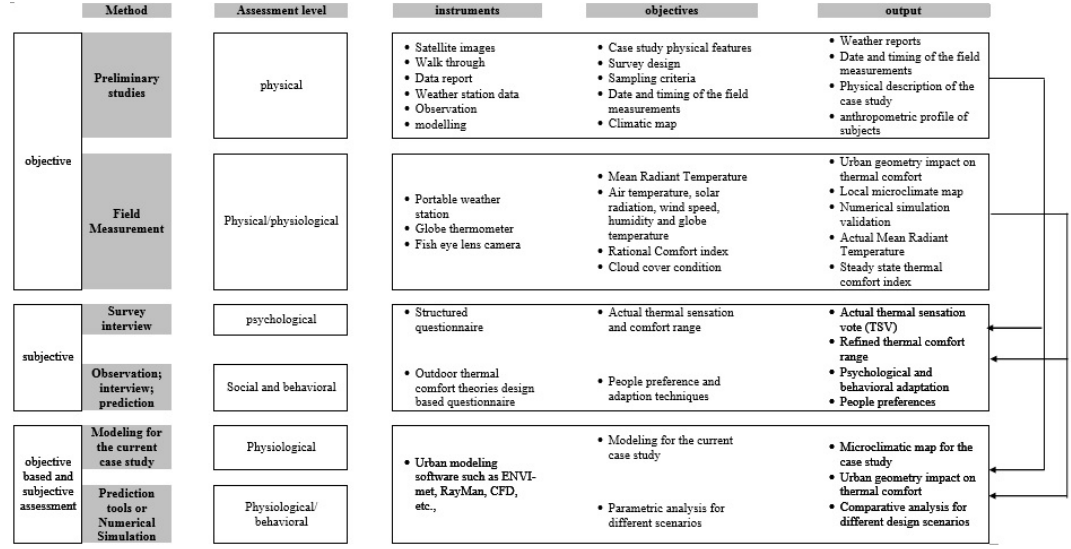
Figure 1. A proposed assessment framework for outdoor thermal comfort.